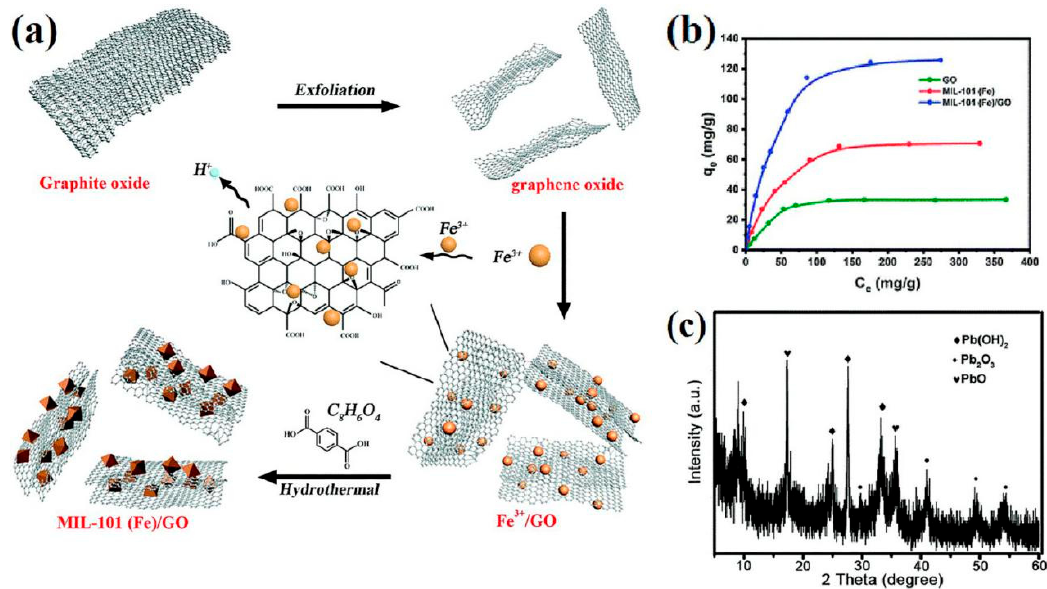
Figure 5. ( a ) Schematic illustration of the synthesis of MIL-101(Fe) / GO with a sandwich structure via a hydrothermal method; ( b ) Pb 2 + adsorption isotherms for GO, MIL-101(Fe) and MIL-101(Fe) / GO at room temperature; ( c ) XRD pattern of MIL-101(Fe) / GO after Pb 2 + adsorption. Reproduced with permission from [83]. Copyright Royal Society of Chemistry,